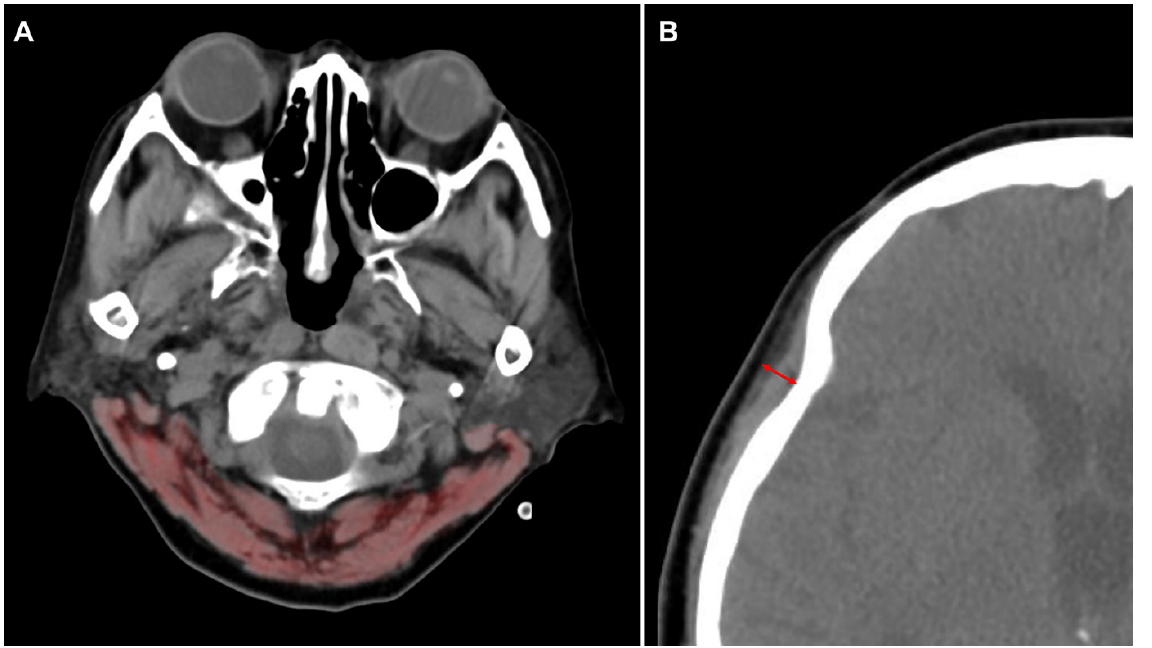
Figure 3. Methods for the measurement of the cross-sectional area at the level of first cervical verte- bra (C1-CSA) ( A ) and temporalis muscle thickness (TMT) ( B ) on brain computed tomography im- A ) and temporalis muscle thickness (TMT) ( B ) on brain computed tomography ages. (C1-CSA) (